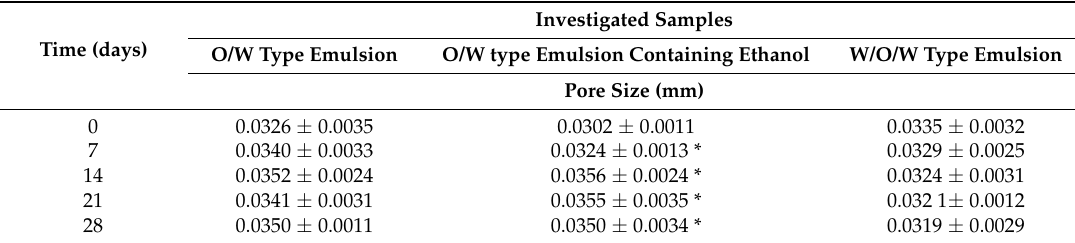
Figure 4. The effect of the O/W type emulsion containing ethanol on the skin condition after 0, 7, 14, 21 and 28 days. N = 42 volunteers. Table 3. The influence of the investigated emulsions on the skin pore